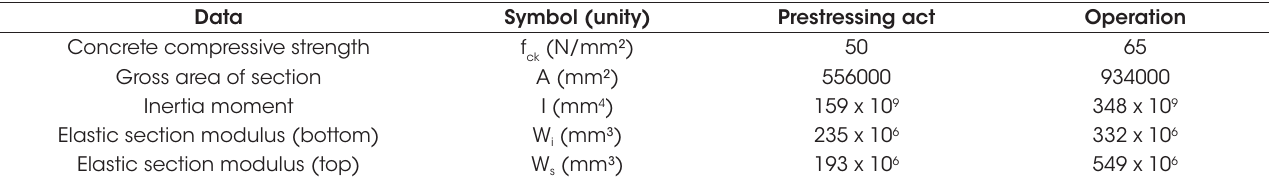
Design (nominal) geometric and material properties of selected girder for design (Beam 1) at prestressing act and